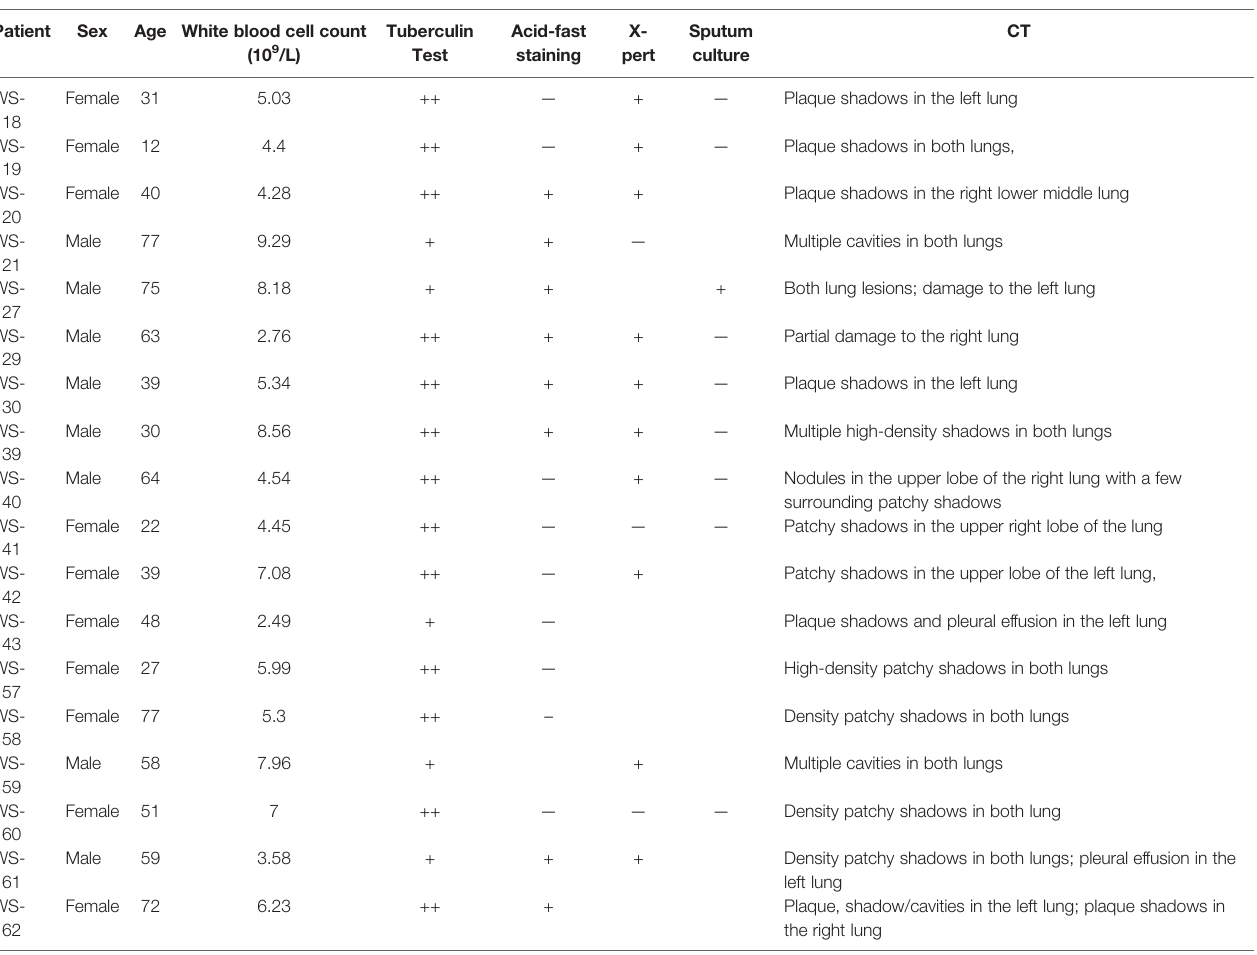
“ ++ ” strong positive, “ + ” positive, “—”